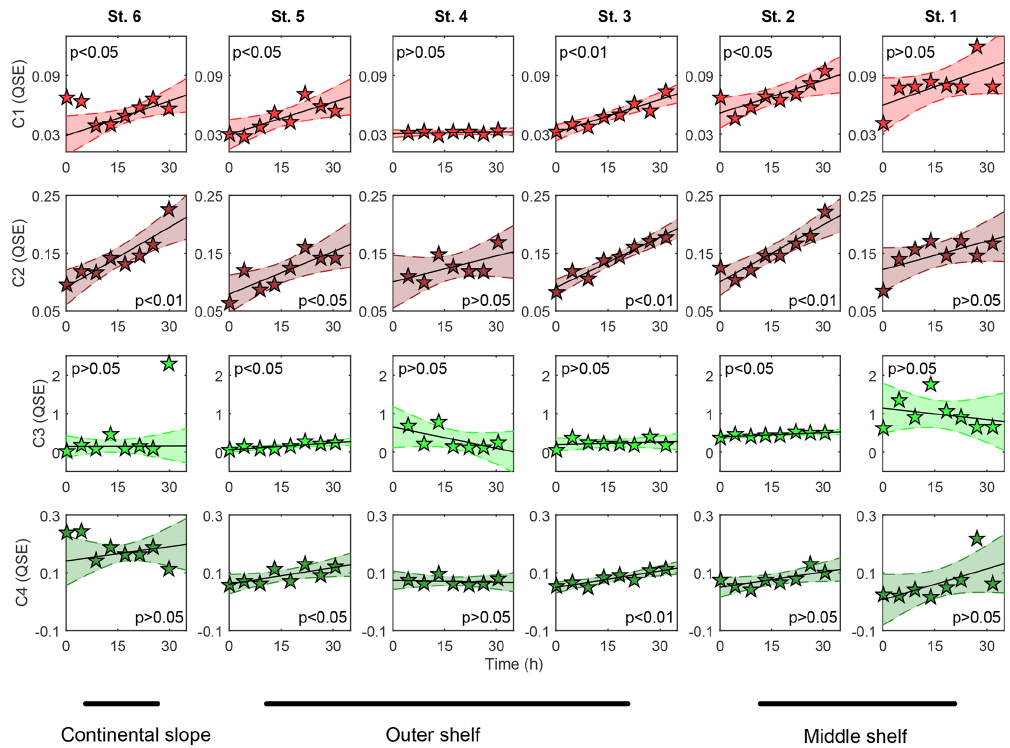
Figure 7. Distribution of FDOM components, measured in BIGO chambers over time. Polynomial fit (first order) was used for linear regression analyses: t 0 values were excluded from the